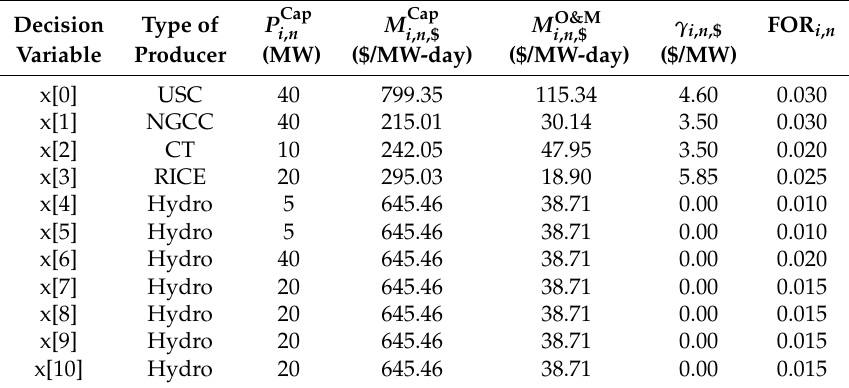
Table 2. Characteristics of the producers [34,36].